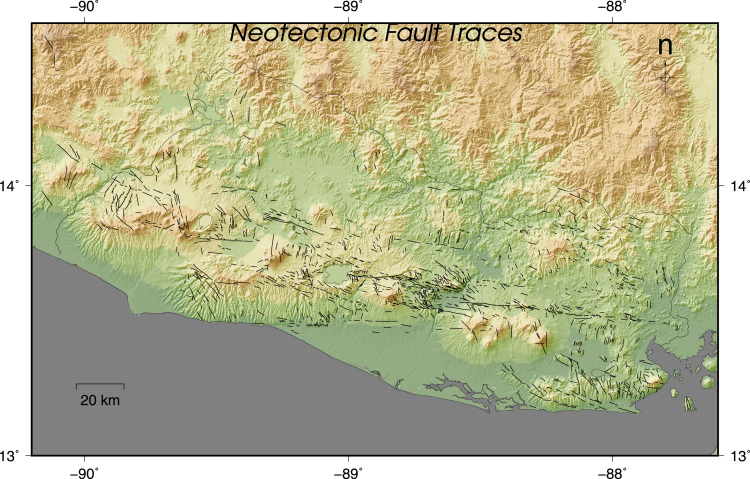
Qauternary Fault Traces used for the mapping of the seismic sources in Fig. 2.